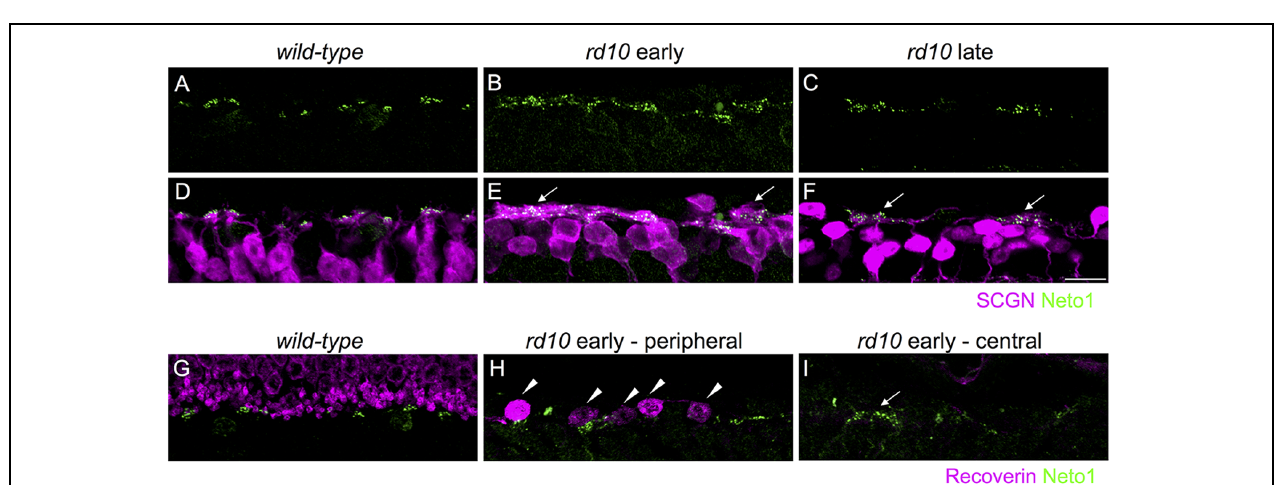
FIGURE 3 | Kainate receptors cluster in remodeled bipolar cell dendrites and persist in the absence of residual photoreceptors in rd10 retina. (A–C) Clusters of Neto1 puncta in wild-type and rd10 outer retina. (D–F) Same regions as in (A–C) showing double labeling for Neto1 and secretagogin. Note that Neto1 puncta are associated with remodeled cone bipolar cell dendrites in both the early and late rd10 age groups (arrows). (G–I) Regions of outer retina double labeled for recoverin and Neto1 in wild-type and rd10 retina at the early time-point. Note the recoverin-labeled photoreceptor terminals in the wild-type retina (G) . Some residual dysmoprhic cones (arrowheads) remain in the peripheral rd10 retina (H) , however, in the central retina Neto1 clusters (arrow) remain despite the lack of any residual cones. Scale bar = 10 μ m.